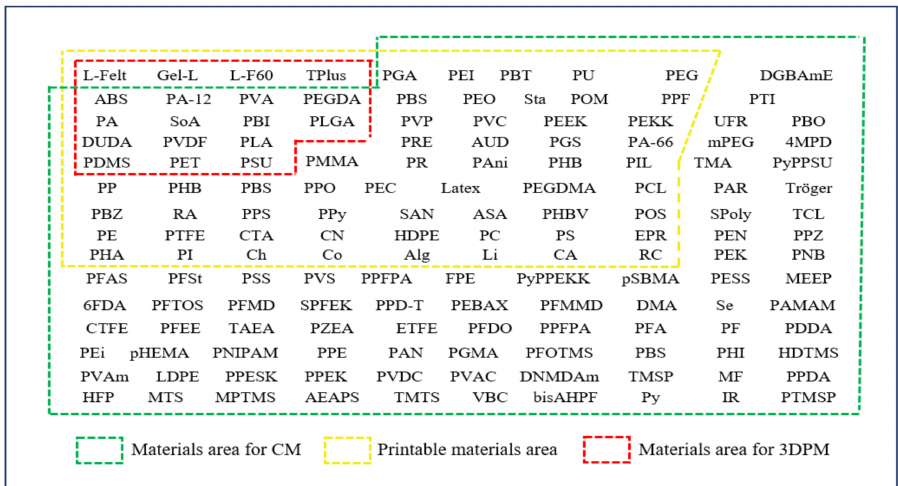
Figure 3. Polymers used for the manufacture of membranes: conventional membrane (CM) vs. 3D-printed membrane (3DPM)